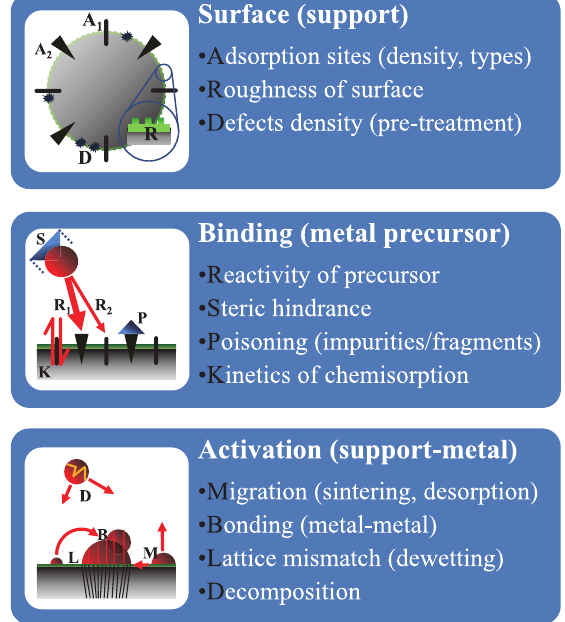
Fig. 1 Island growth dependence on surface-, binding- and activation-related parameters during the ALD of noble